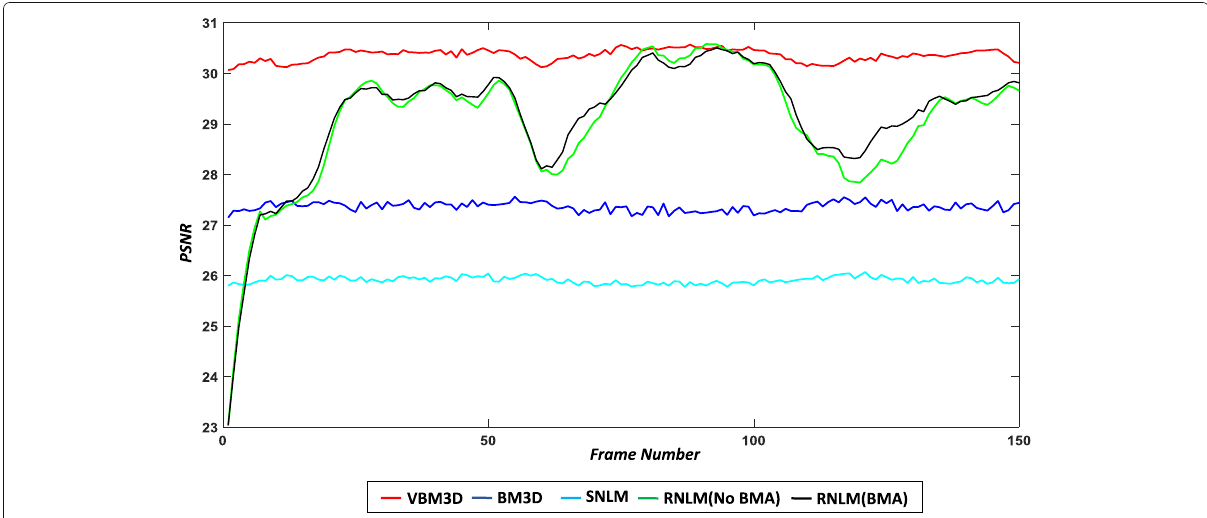
Fig. 3 PSNR (dB) versus frame number using several methods for the Salesman sequence corrupted with a noise level of σ = 40. With no background motion, RNLM with and without BMA perform about the same. VBM3D gives the best performance for this